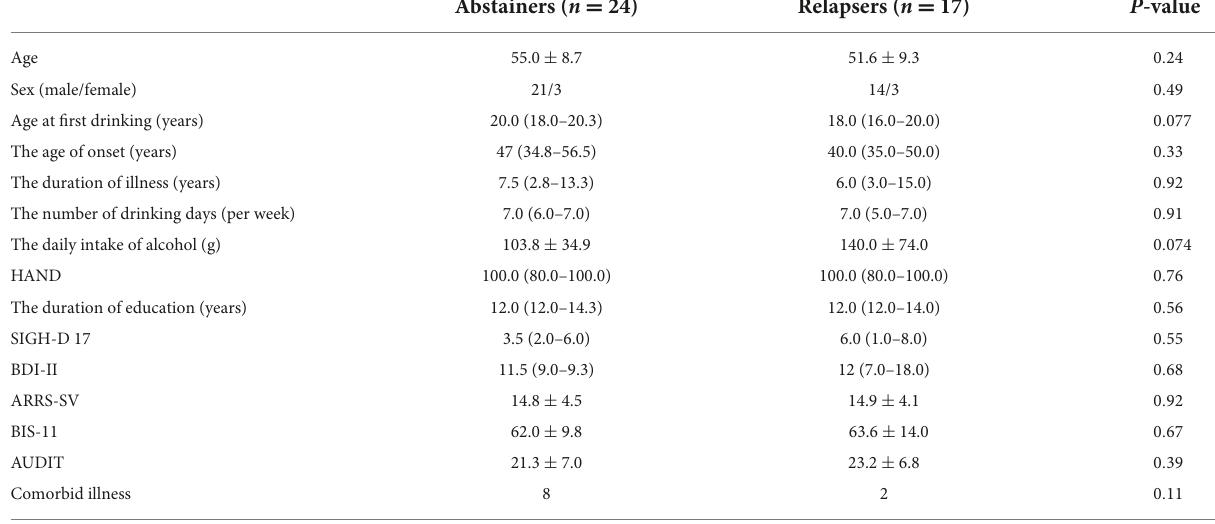
TABLE 1 Sociodemographic data of the